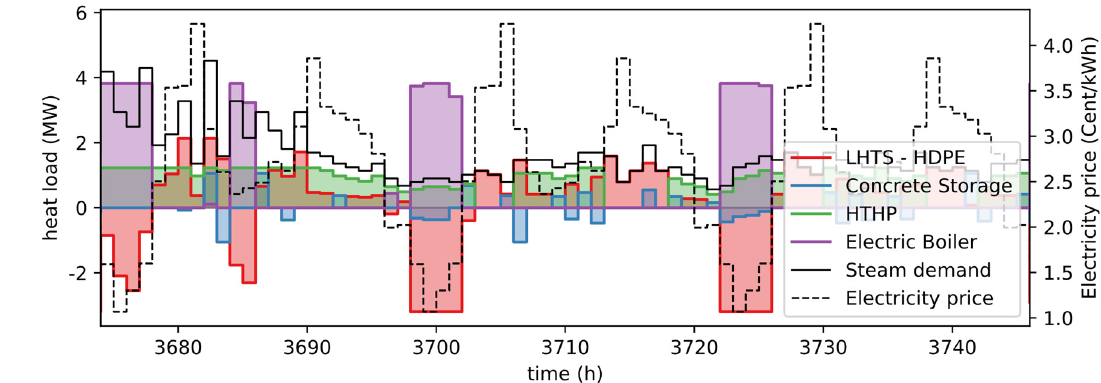
Figure 16. Cutout of the thermal storage and steam generator loads, steam demand and electricity price profiles for Case 2.